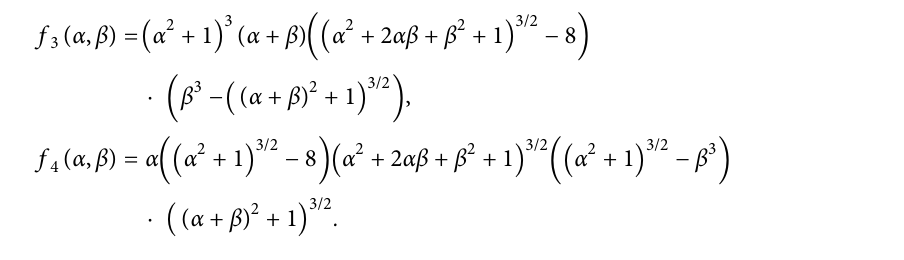
Figure 17: Case I: α � 0 . 1, (a) μ � 33 . 8017, (h) μ (g) μ 3